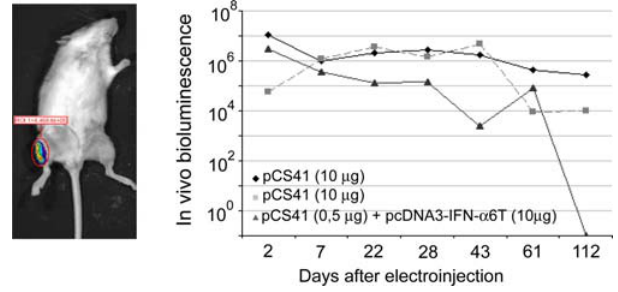
Figure 3. Expression of luciferase, in vivo, after i.m. electro- injection of an expression plasmid. Left panel: picture of a mouse showing luciferase expression in the tibialis muscle of the right leg. Right panel: follow-up of luciferase expression in vivo (arbitrary units), in two mice electroinjected with 10 m g of plasmid DNA (pCS41) expressing the firefly luciferase gene and in one mouse electroinjected with 0.5 m g of pCS41 plasmid DNA and 10 m g of plasmid DNA expressing IFN- a